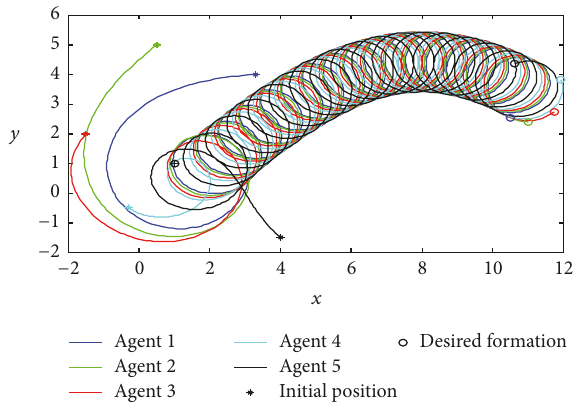
Figure 9: Circular formation trajectories 𝑝 𝑘 (𝑡) with a moving